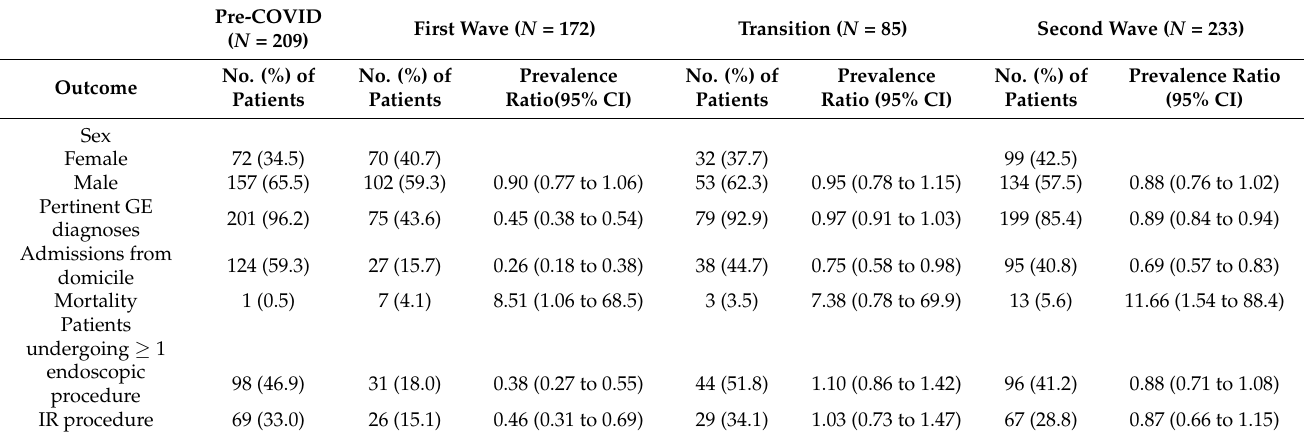
Table 1. Study population.